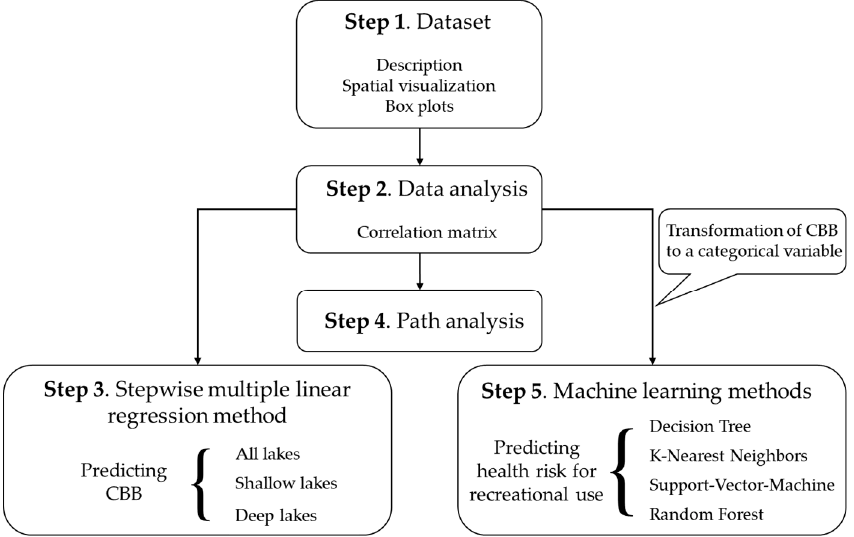
Figure 1. Flowchart describing the steps followed in this study.